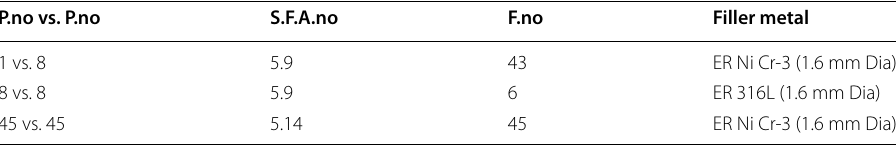
Table 2 P.no, F.no, and S.F.A no of filler metal P.no vs.